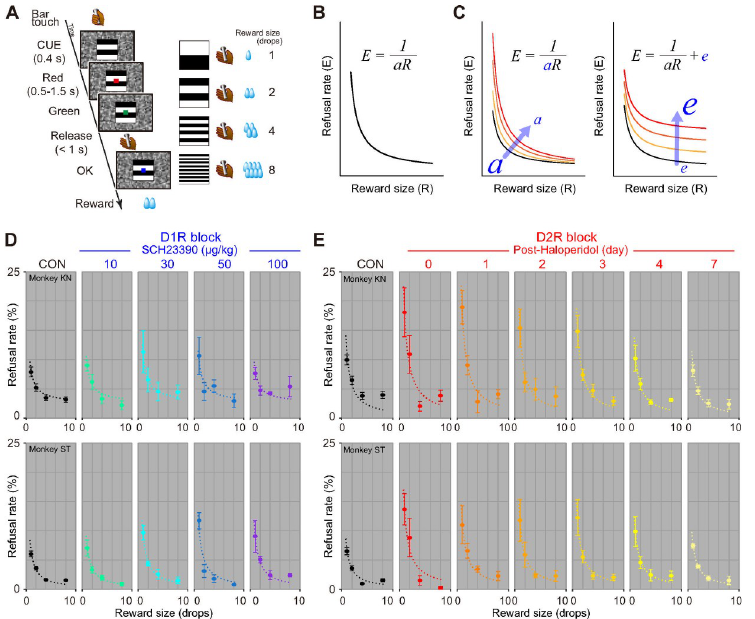
Fig 2. D 1 R/D 2 R blockade increased refusal rates in reward-size task. (A) Reward-size task. Left: sequence of events during a trial. Right: association between visual cues and reward size. (B) Schematic illustration of inverse function between refusal rate and reward size. (C) Schematic illustration of 2 explanatory models of decrease in motivation. Left: increase in refusal rate (i.e., decrease in motivation) in relation to reward size caused by decrease in incentive impact ( a ). Right: an alternative model explaining increase in refusal rate irrespective of reward size. (D, E) Behavioral data under